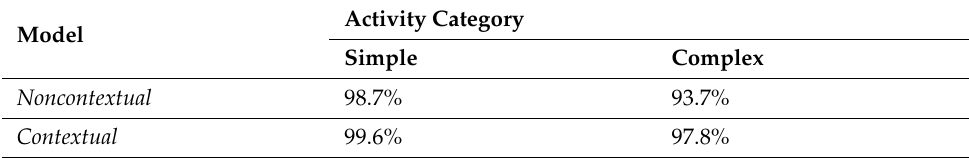
Table 4. Model accuracy by activity category.